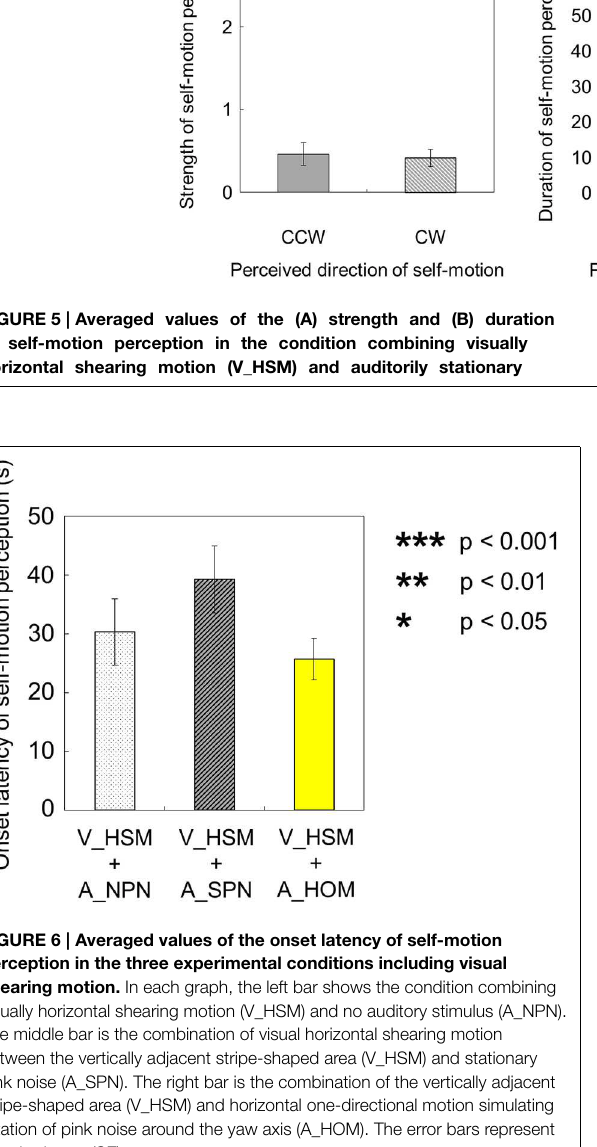
All participants perceived self-motion among the above three experimental